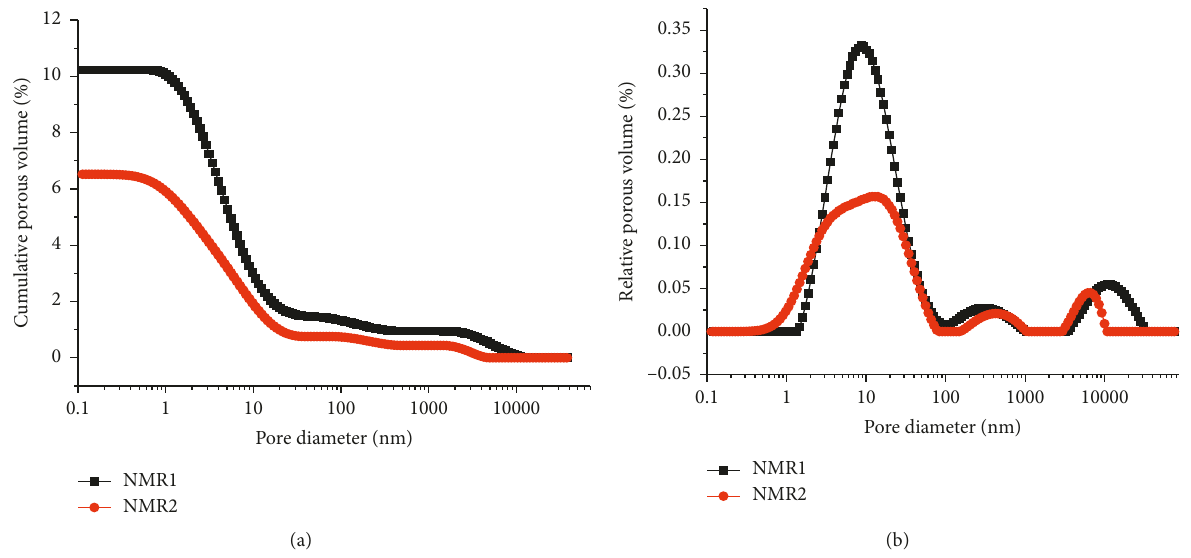
Figure 9: Pore size distribution of hardened cement paste by NMR: (a) cumulative curve; (b) relative curve.